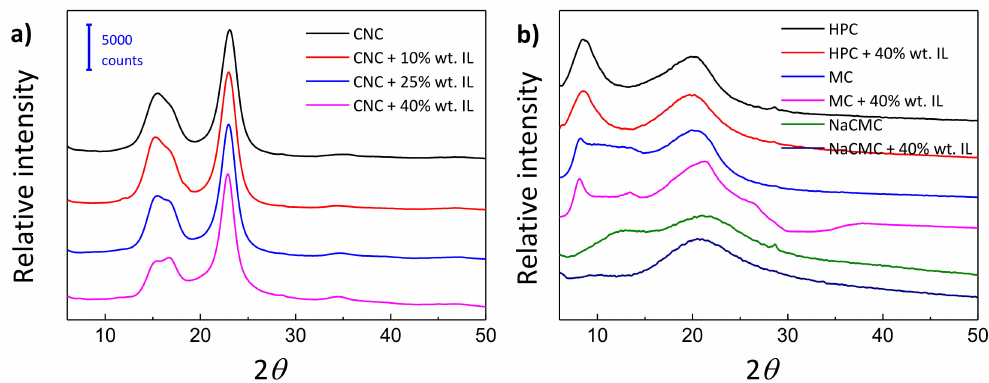
Figure 4. X-ray di ff raction (XRD) patterns of ( a ) pure CNC and CNC / [Ch][DHP] composite films and ( b ) HPC, MC, and NaCMC-based composite films.